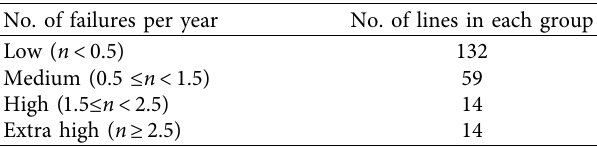
Figure 3: Single line diagram of the Khorasan network. Table 2: Grouping the transmission lines based on the number of annual